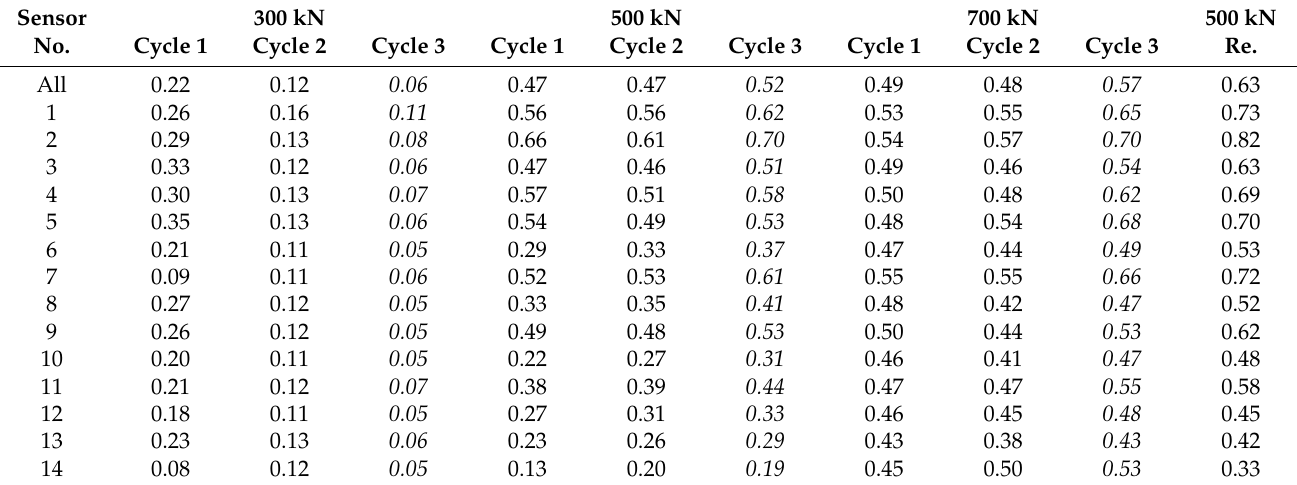
Table 4. Calculated calm ratios for all sensors and all load